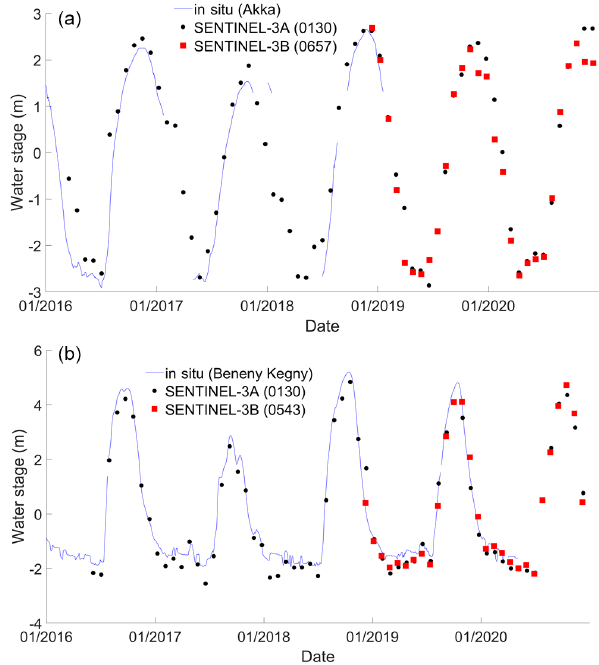
Figure 2. Time-series of water levels from the in-situ gauge stations (blue) of Beneny Kegny (a) and Akka (b) , Sentinel 3A (black dots) and 3B (red squares).